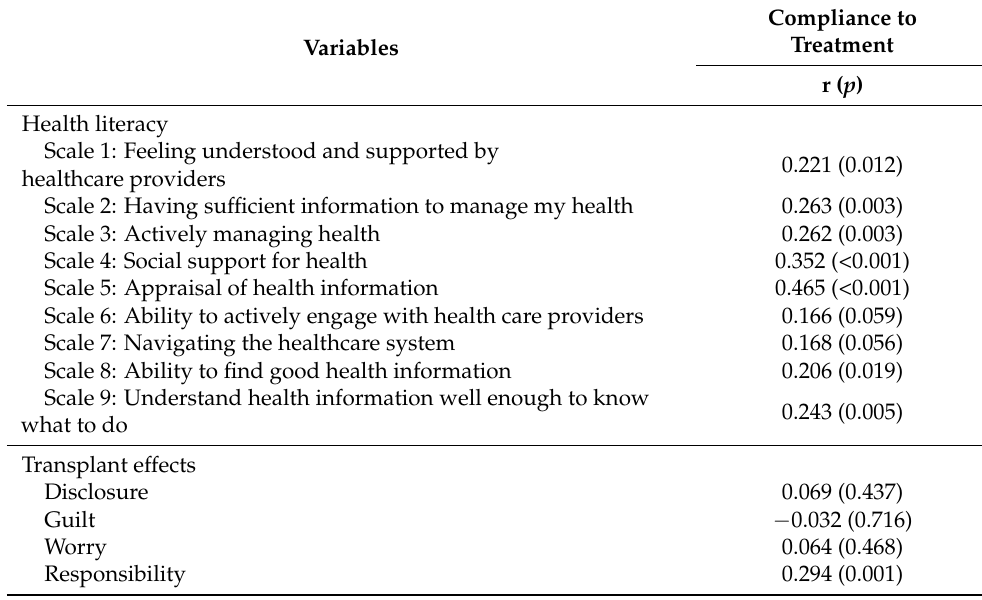
Table 4. Correlation between health literacy, transplant effects, and treatment compliance ( n =